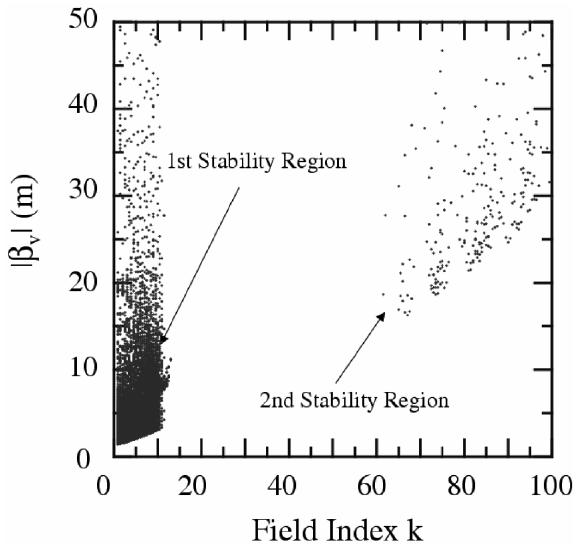
FIG. 3. Magnitudes of vertical (cid:23) function for the case of the 12-cell singlet configuration. The higher order stability islands are associated with large phase advances and betatron oscil-